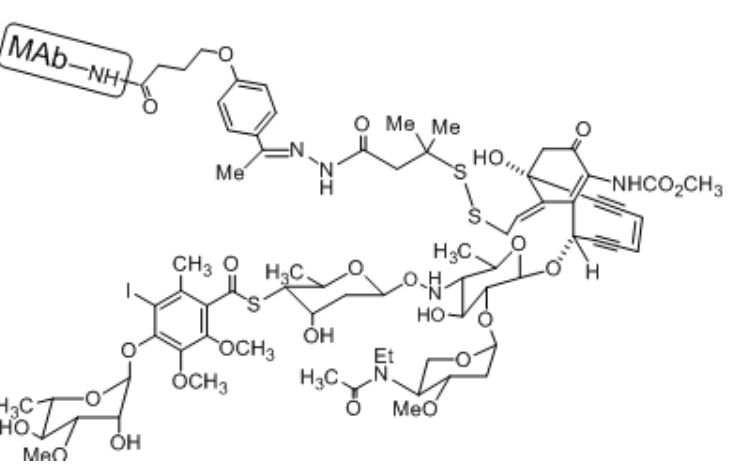
FIGURE 3. Antibody conjugates incorporating highly potent maytansinoids (top), auristatins (middle), or a calicheamicin derivative (bottom).